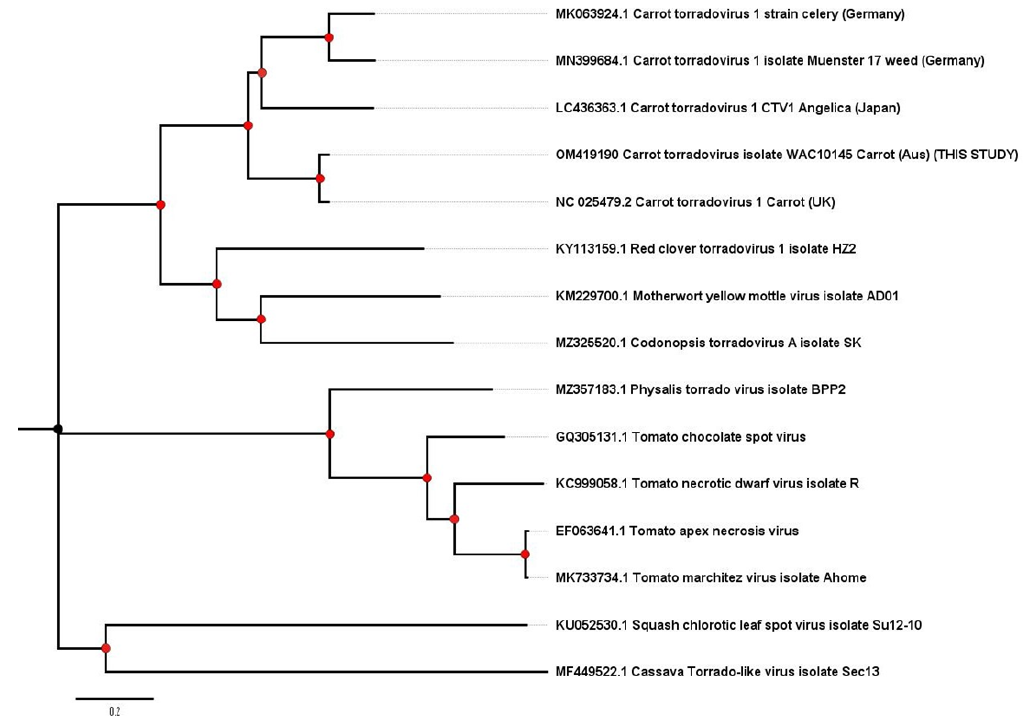
Figure 3 . Phylogenetic tree of complete RNA1 nucleotide sequences of CaTV1 and a range of related torradoviruses. For the CaTV1 isolates, host and country of isolation are included.